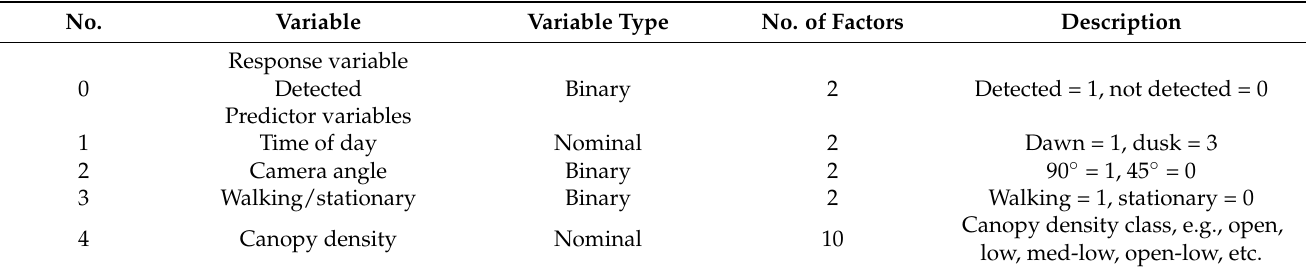
Table 1. A summary of the variables used for statistical analysis including their